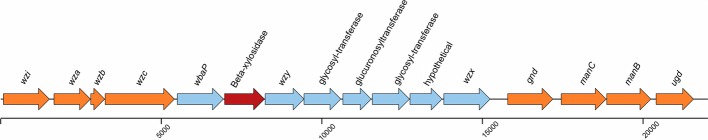
The architecture of the novel capsule biosynthesis cluster (cps) in the ST15 Outbreak Lineage 1 Klebsiella pneumoniaeGraphical representation showing the composition of the cps gene cluster within the Outbreak Lineage 1 K. pneumoniae isolates. The genes are identified by either their common name (e.g. wbaP) or their predicted function (e.g. beta-xylosidase). Genes that are shared by other strains of K. pneumoniae are coloured orange, and genes specific to this cps cluster are coloured blue and red. The beta-xylosidase gene (red) was selected as the target for lineage-specific PCR amplification.